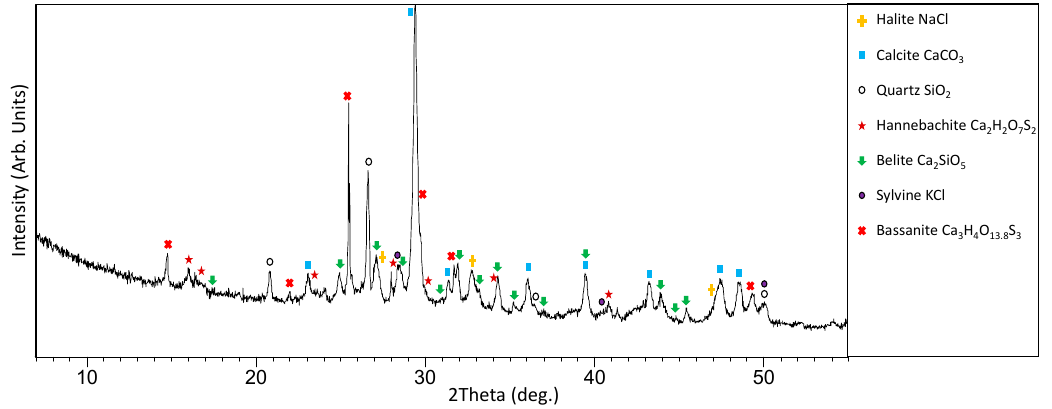
Figure 3. X-ray di ff raction (XRD) pattern of stabilized fly ash (FA) after 11 Figure 3. X-ray diffraction (XRD) pattern of stabilized fly ash (FA) after 11 months.